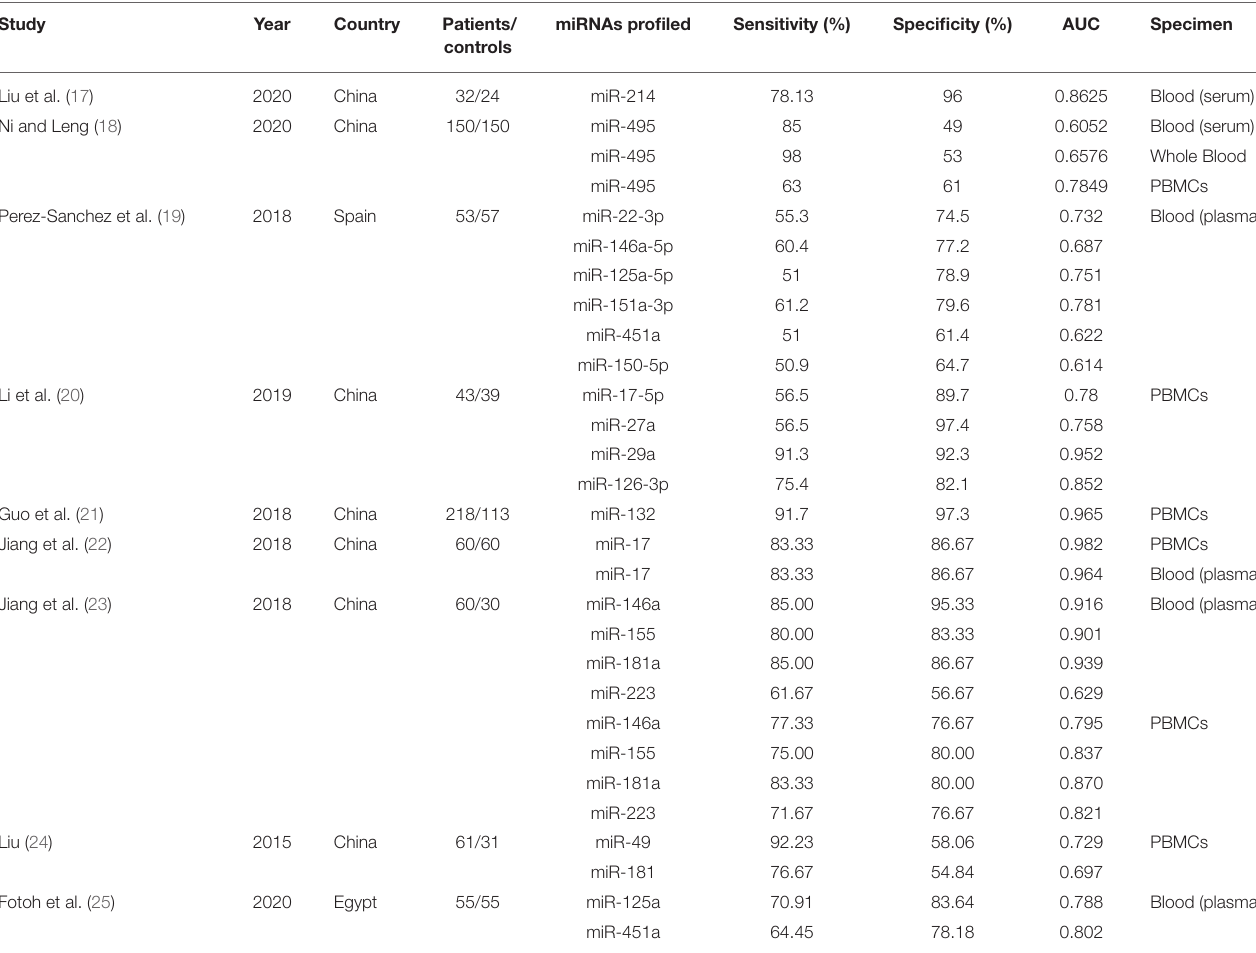
TABLE 2 | Characteristics of the nine reports in our meta-analysis.